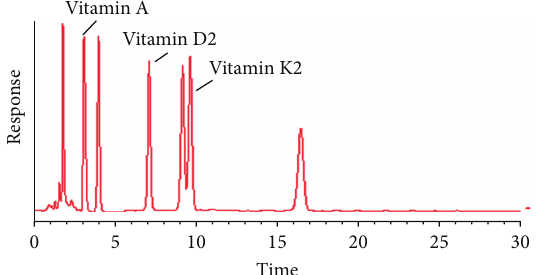
Figure 3: HPLC chromatogram of fat soluble vitamins extracted by reverse phase HPLC method. Quantitative data were corrected for differences in detector responses through analysis of authentic standards of each reported vitamin.